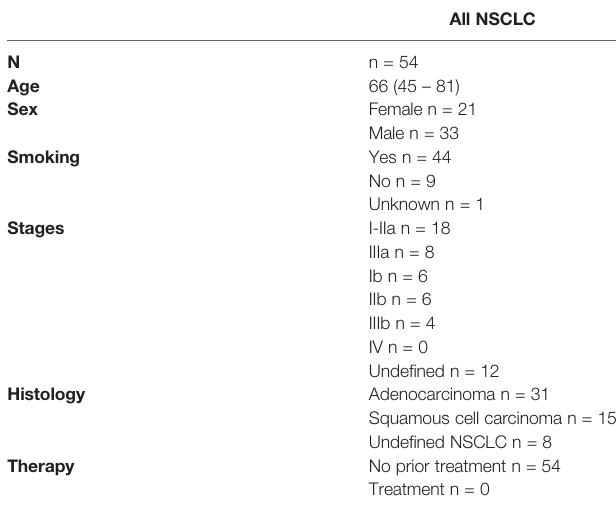
TABLE 1 | Participants